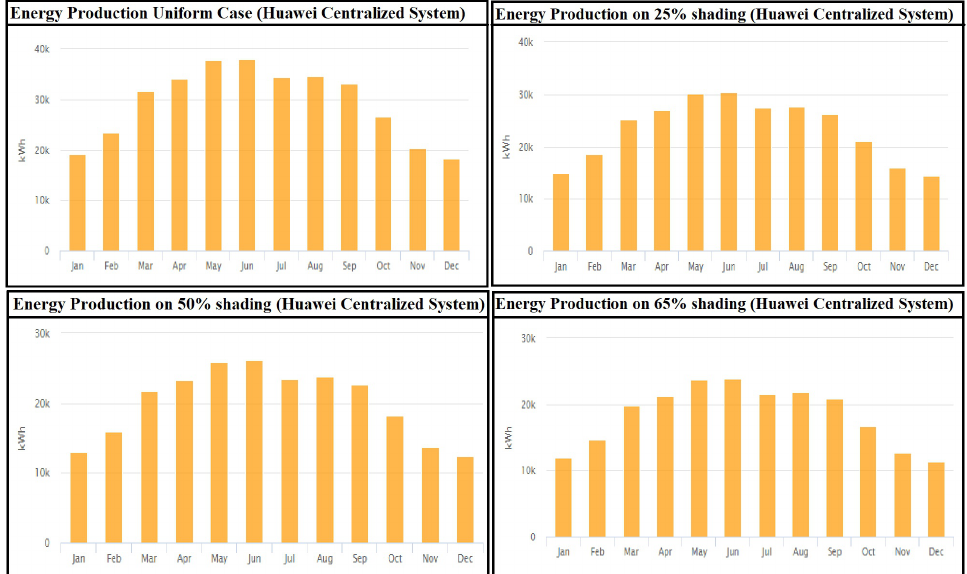
Figure 44. Results of energy production of Huawei centralized system on different shading conditions using